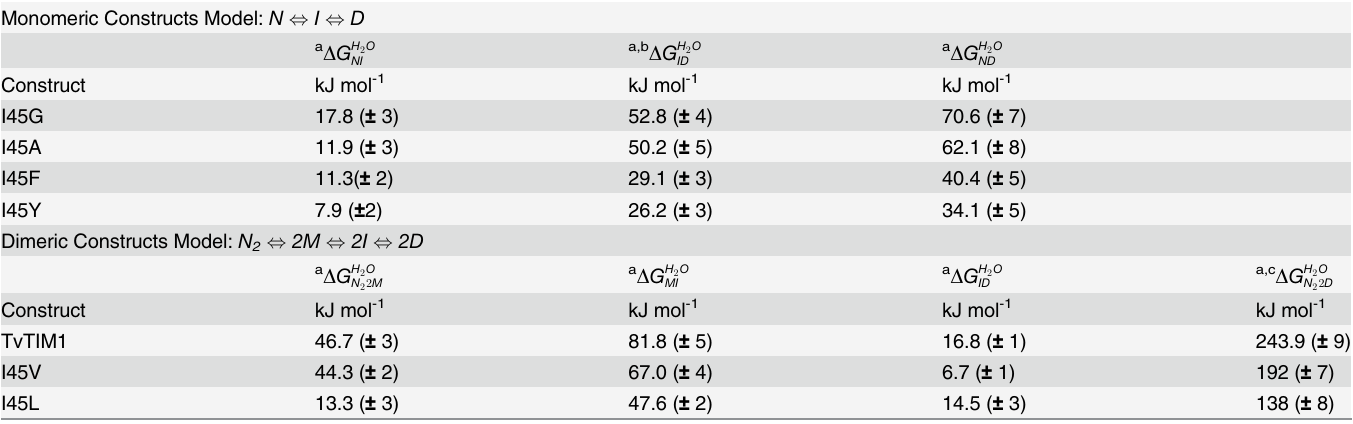
Table 2. Thermodynamic Parameters for TvTIM1 and I45X